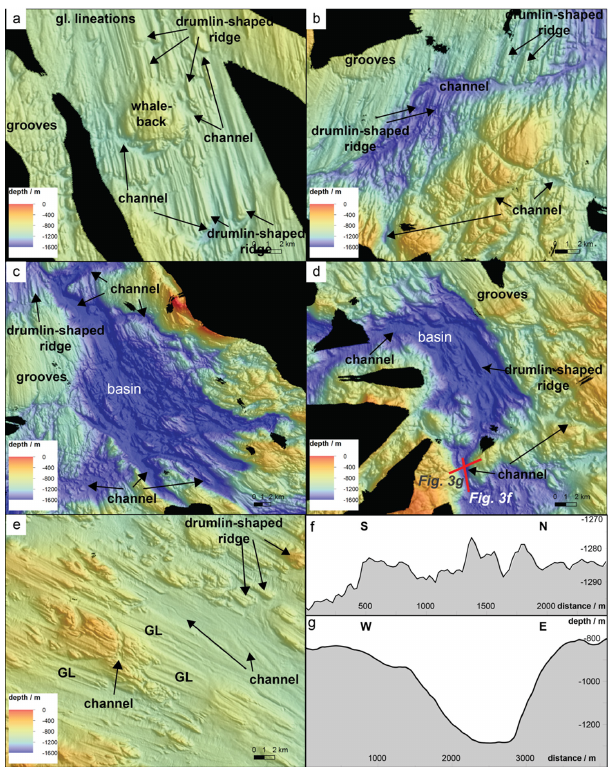
Fig. 3. (a–e) Detailed examples of morphological features includ- ing glacial lineations (GL), basins, channels, drumlin-shaped ridges and grooves. (f) Undulating thalweg and (g) cross-section of large channel marked in (d) .